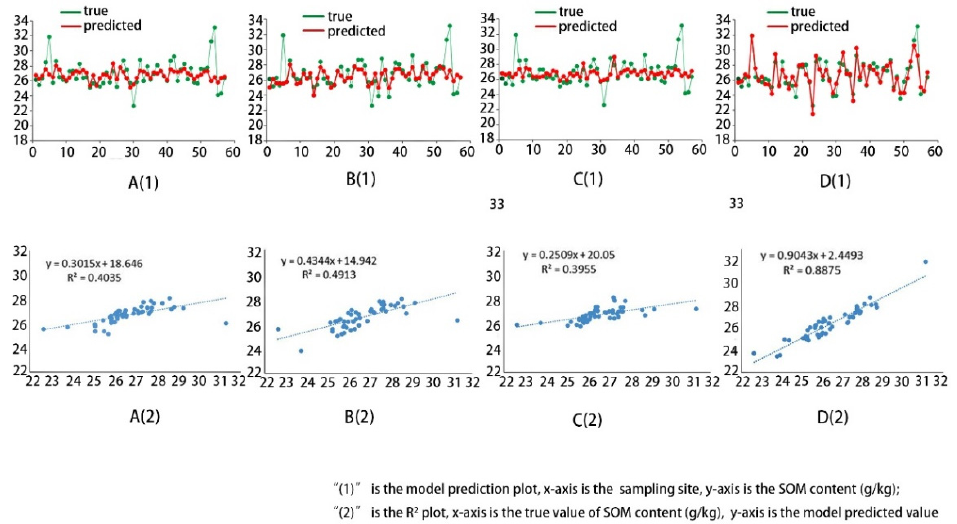
Figure 11. The results of different models: ( A ) support Vector Machines (SVM); ( B ) Random Forest (RF); ( C ) LeNet-5; ( D ) improved model.